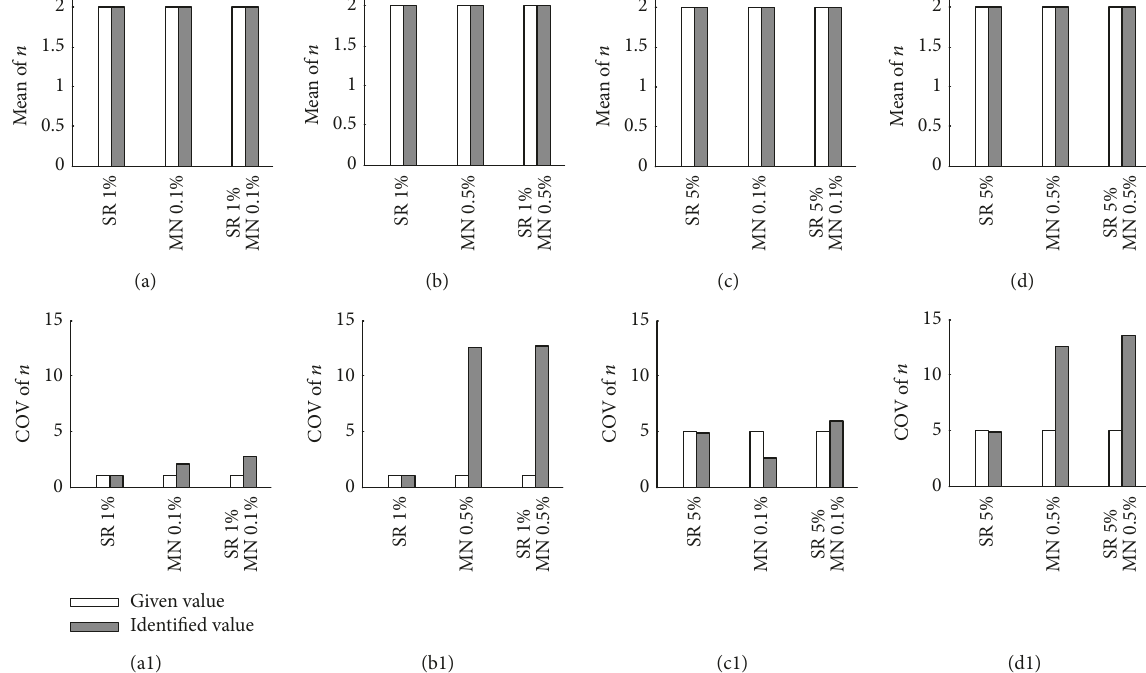
the identified PDFs for 300 K and 600 K, respectively, when the FGM beam along its axial direction is considered. It can be seen that the identified results for the FGM beam along its axial direction are more close to the given PDFs than those for the FGM beam through its thickness direction. Compared to the given PDFs, Figures 10(b), 11(b), and 12(b)